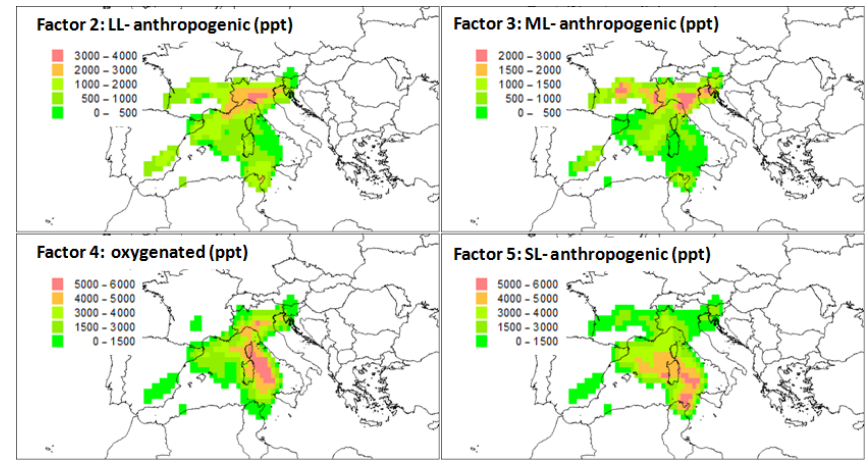
Figure 8. Source identification for the six gas-phase PMF factors using the CF model. Contributions are in parts per trillion (ppt).